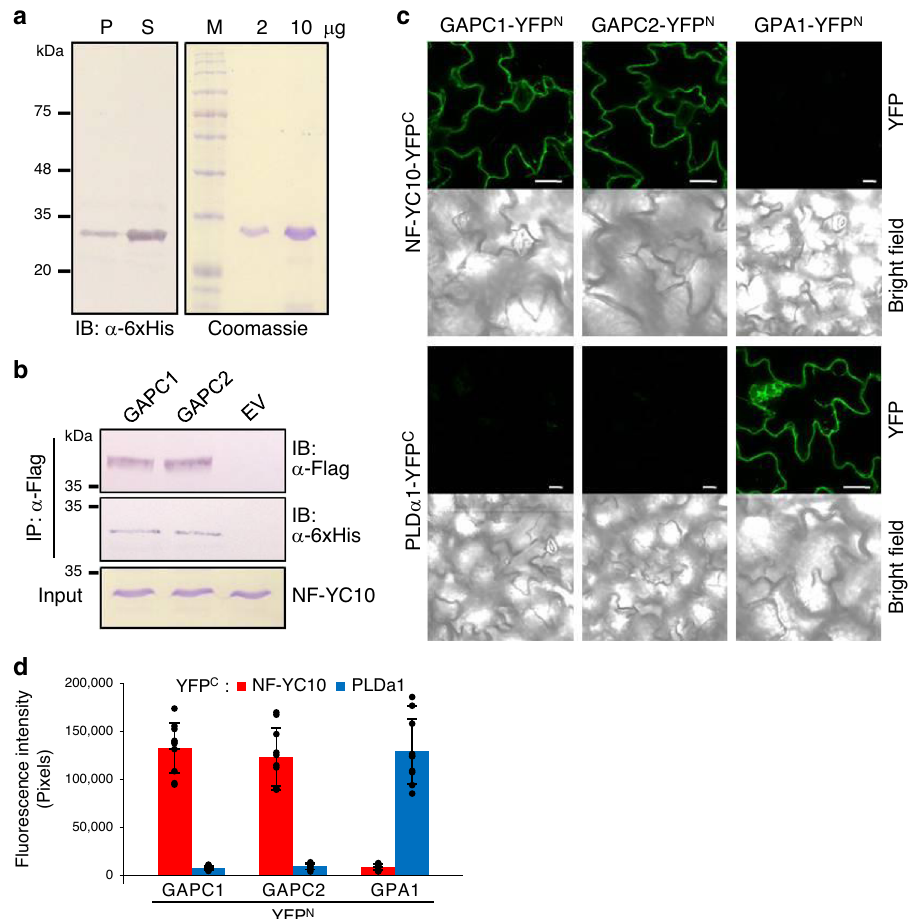
Fig. 2 Physical interaction of GAPC with NF-YC10. a Expression and puri fi cation of recombinant NF-YC10 produced in E. coli . Proteins from pellet (P) or supernatant (S) following centrifugation of E. coli cell lysate were separated, and NF-YC10-6xHis was probed by immunoblotting (IB) with an anti-6xHis antibody (left panel). Protein marker size is on the left. NF-YC10 was nickel af fi nity-puri fi ed from the E. coli and shown here on polyacrylamide gel stained with Coomassie blue (right panel). M, marker. b Co-immunoprecipitation of GAPC and NF-YC10. GAPC1-Flag, GAPC2-Flag, or empty vector control (EV) was mixed with NF-YC10-6xHis. Immunoprecipitation (IP) was performed using an anti-Flag antibody, then immunoblotting (IB) was performed using the antibodies indicated on the right. NF-YC10 protein input is shown on polyacrylamide gel stained with Coomassie blue (bottom panel). c Bimolecular fl uorescence complementation (BiFC) analysis. GAPC-YFP N and NF-YC10-YFP C were transiently co-expressed in tobacco leaves and observed under a confocal microscope. GPA1 and PLD α 1 that bound each other were used as controls. Scale bars = 10 µ m. d Quanti fi cation of BiFC. Fluorescence intensity of tobacco leaves used in c was measured by ImageJ software. Values are average ± S.D. from 10 randomly chosen regions of tobacco leaves in fi ltrated. Black dots represent individual